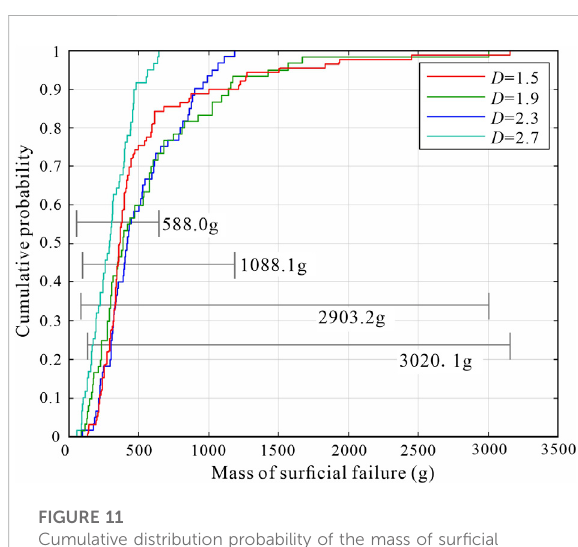
FIGURE 11 Cumulative distribution probability of the mass of sur fi cial